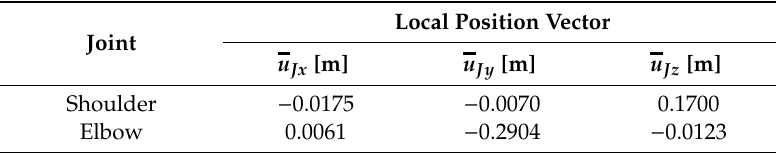
Table 3. Joints’ positions with respect to the reference